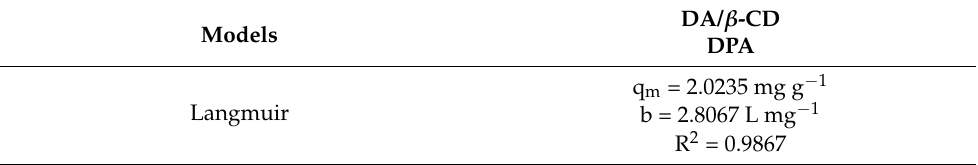
Table 1. Isothermal parameters of DPA adsorption by DA/ β -CD.